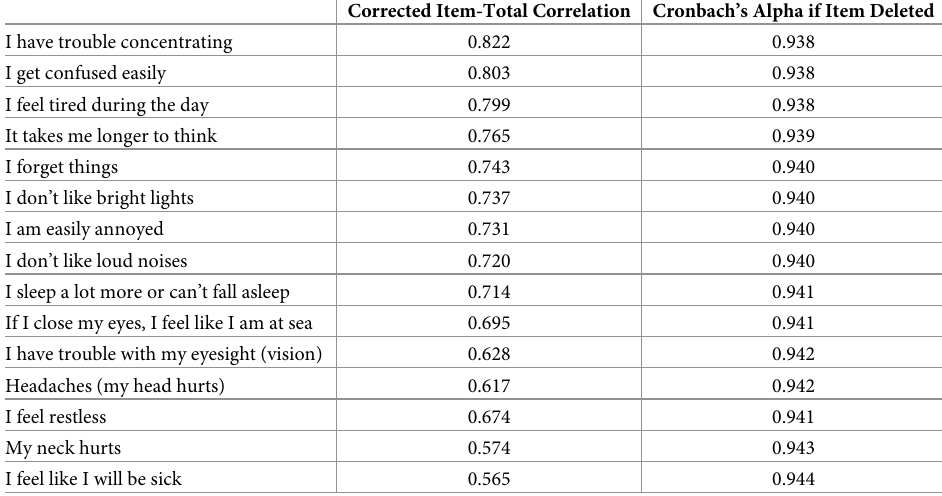
Table 3. Relationships between items within the BIST and contribution of items to the overall